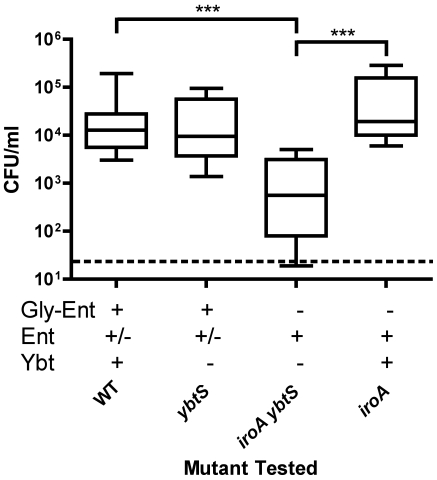
Enterobactin-dependent K. pneumoniae is defective in colonization.Colonization density at day 3 after intranasal inoculation with 2×106 cfu of the K. pneumoniae mutants indicated was determined in C57BL/6 mice (n≥5 mice per group). Box and whiskers graph shows the median and interquartile ranges; the dashed line is the lower limit of detection (20 cfu/ml). Siderophores encoded by each mutant are indicated by a plus (+). *** p<0.001 as determined by Kruskall-Wallis Test with Dunn's post test.